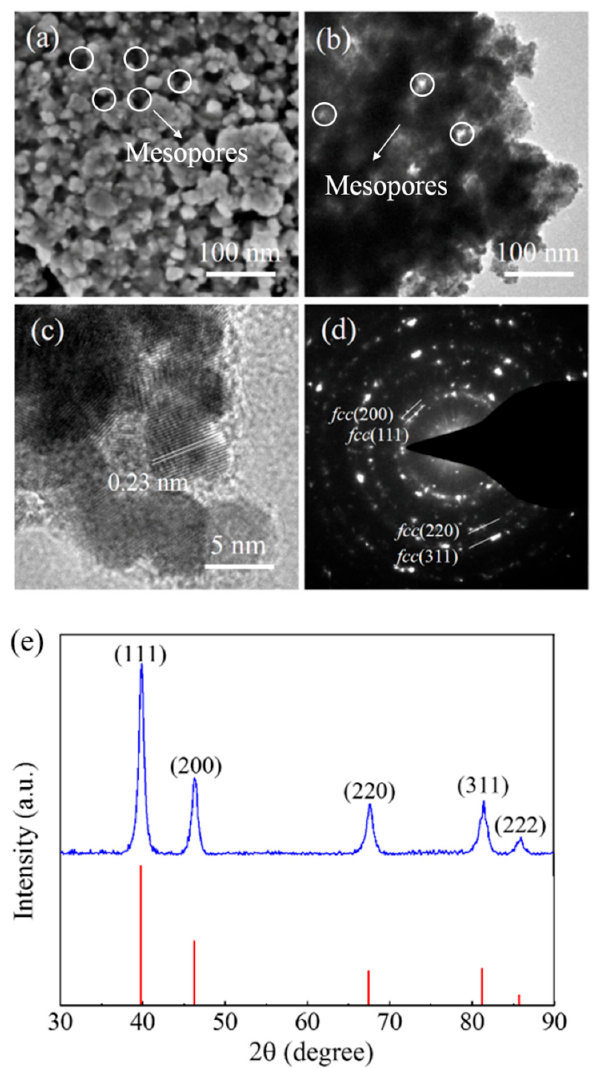
Figure 3. ( a ) SEM and ( b ) TEM images of mesoporous Pt-350 particles prepared from triblock copolymer PS 192 - b -P2VP 143 - b -PEO 613 . ( c ) High-resolution TEM image focusing on the edge of mesoporous Pt-350 particles. ( d ) The corresponding electron diffraction (ED) patterns of (111), (200), (220) and (311) planes can be assigned to a fcc crystal. ( e ) XRD analysis with the red vertical lines representing the diffraction peaks of bulk Pt (JCPDS Card No. 65-2868).